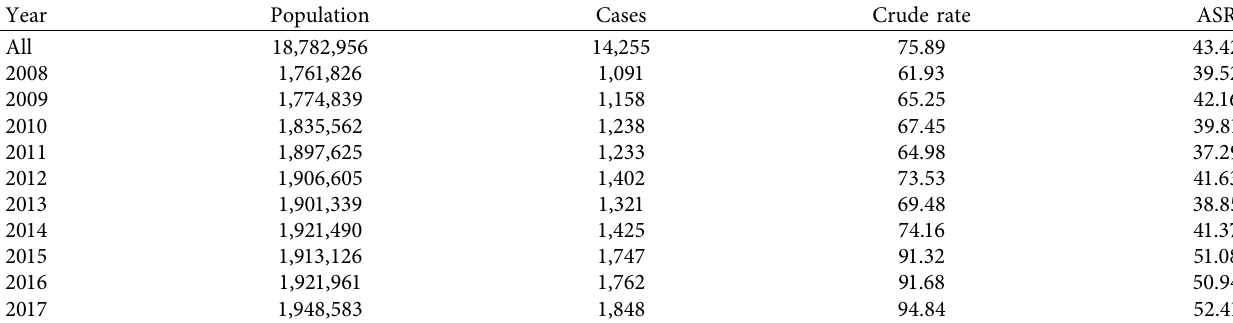
Table 1: Incidence of female breast cancer in urban Shenyang in 2008–2017.